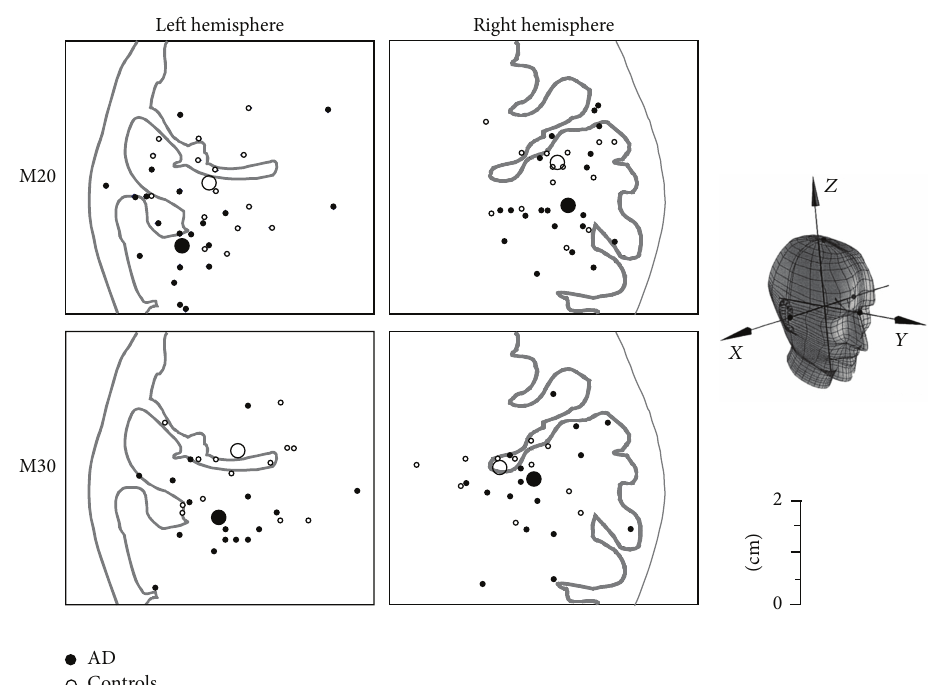
Figure 2: M20 and M30 ECD positions. Positions of individual M20 (top) and M30 (bottom) ECDs in healthy controls (empty dot) and AD patients (black dot) and of the average across the two groups (larger circles) projected on a representative axial graphic rendering in the region of the hand control. Right side : spatial coordinate system: the 𝑦 -axis runs through the midpoint between the subject’s preauricular points and his/her nasion; the 𝑧 -axis is the line perpendicular to the 𝑦 -axis that passes through the vertex; the 𝑥 -axis is the line perpendicular to both 𝑦 and 𝑧 -axes that runs through their intersection. The intersection of the 𝑥 -, 𝑦 - and 𝑧 -axes is the origin of the subject-based coordinate system, and 𝑥 is positive on the head’s right side, 𝑦 towards the nasions and 𝑧 towards the